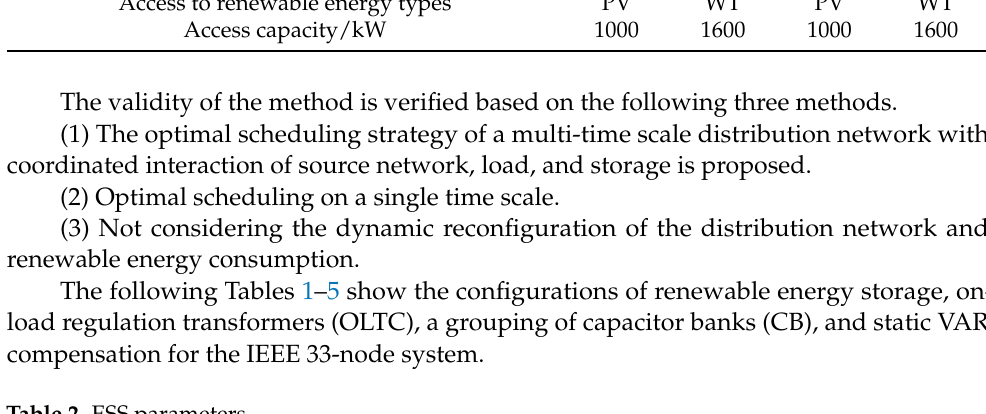
Table 2. ESS parameters.